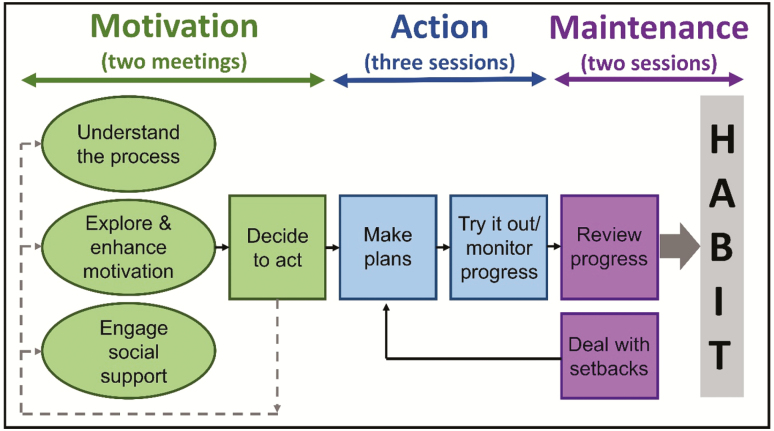
The Process Model of Lifestyle Behaviour Change, an adapted version of the Health Action Process model (Greaves, Reddy, & Sheppard, 2010).